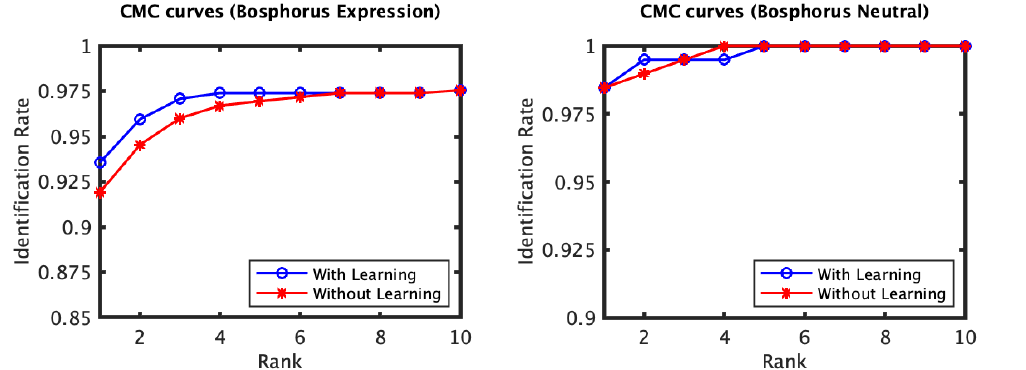
Figure 7. The CMC curves of the Bosphorus dataset (RAIK descriptor).